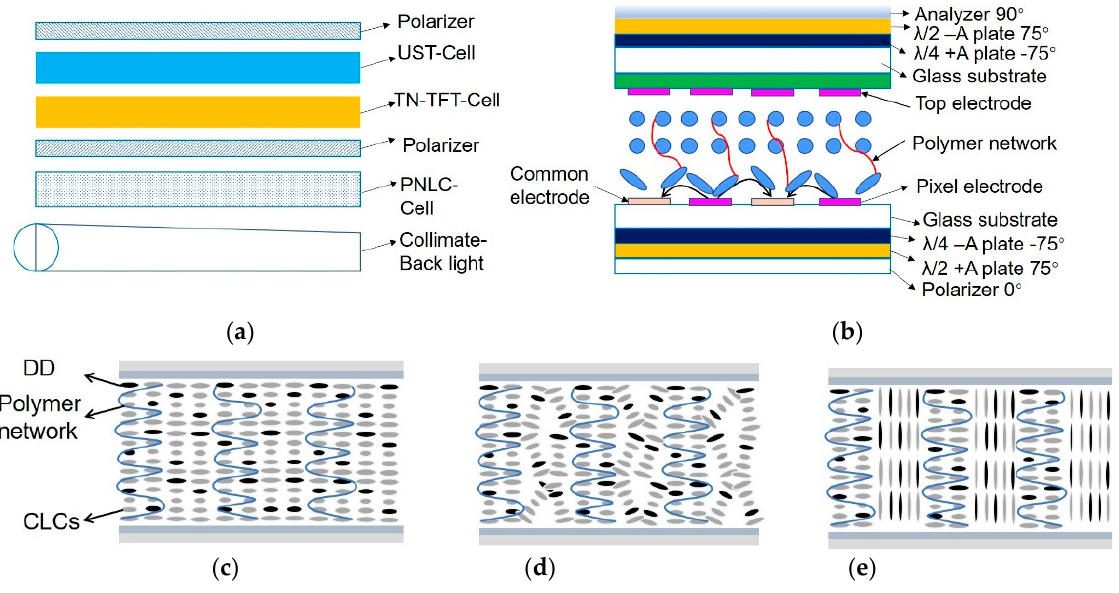
Figure 4. ( a ) Structure of a viewing angle controllable device; ( b ) Cell structure of the proposed viewing angle-controllable PSBP-LCD; ( c – e ) Various states of CLCs in the DD-PSCLC device under the application of electric field: ( c ) planar state; ( b ) focal conic state; ( e ) homeotropic state.